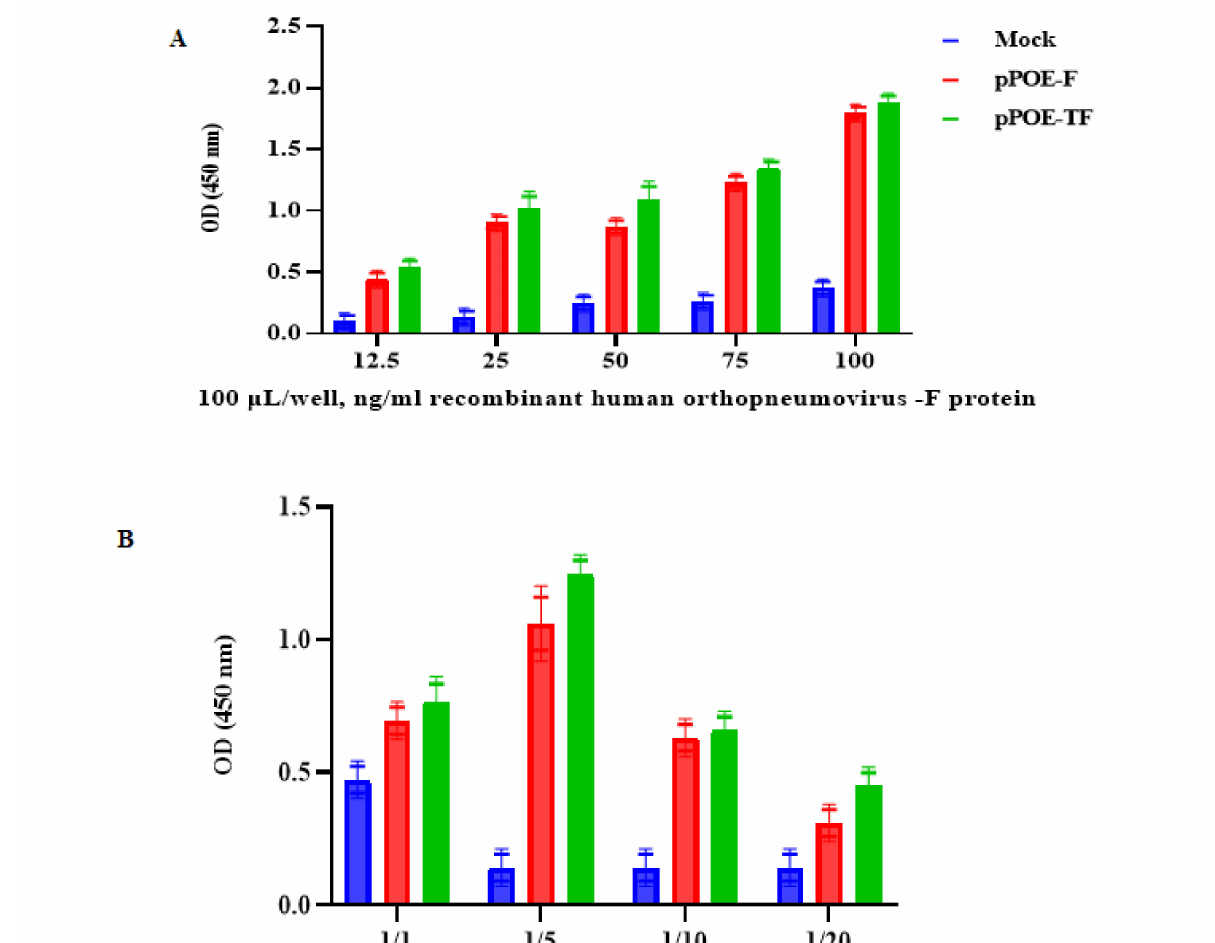
Figure 7. ( A ) Graph showing optimum concentrations of capture recombinant human orthopneu- movirus F protein for each MPA; various concentrations of recombinant human orthopneumovirus F protein were adsorbed in microtiter wells and tested for their ability to bind with pPOE-F and pPOE-TF antibodies, and detected using HRP-conjugated goat anti-rat secondary antibody. ( B ) Graph showing optimum dilution of antibodies raised against pPOE-F and pPOE-TF within the antigen– antibody mixture; five dilutions of each MPA were tested by adding 50 µ L of 1:1,1:2, 1:5, 1:10, or 1:20 to 50 µ L/well, 25 ng/mL in 1% blocking. OD values are the mean of two independent experiments and bars represent means ± SD measured in each MPA. Differences between rats immunized with pPOE-F and pPOE-TF were statistically